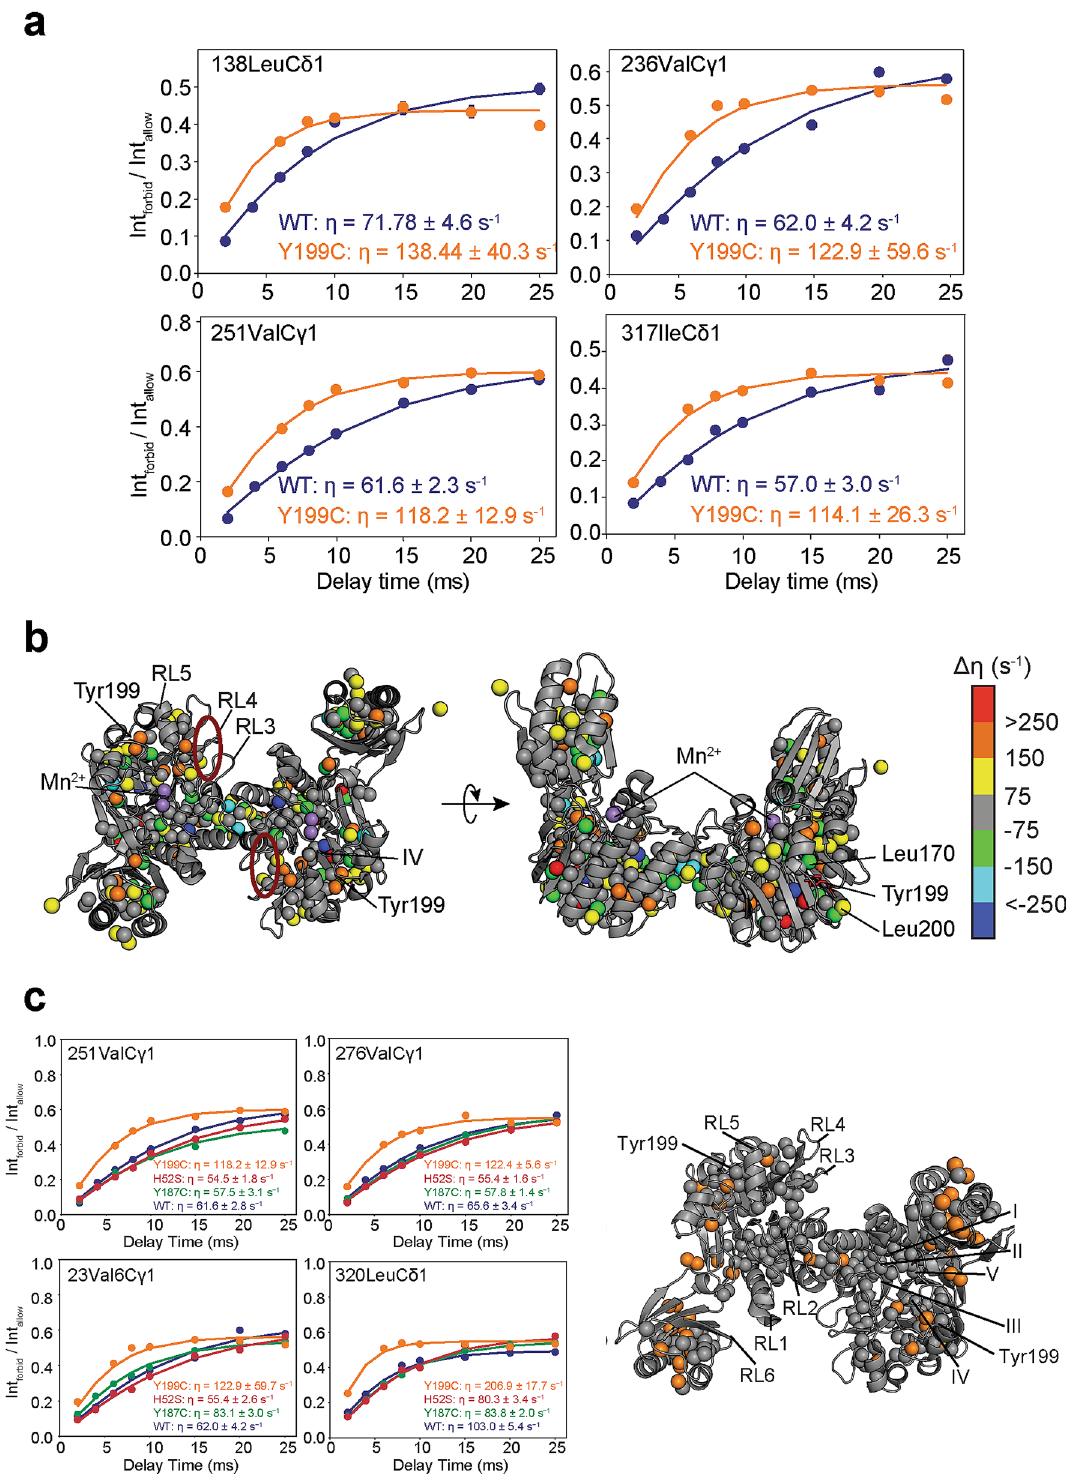
Figure 4. Pf Mre11 Y199C decreases the flexibility of the nuclease and capping domains. ( a ) Representative 1 H– 1 H cross- correlated “forbidden” triple-quantum relaxation curves. The data for wild type and Y199C are colored blue and orange, respectively. Error in the data points is derived from the noise in the spectra. The solid lines represent the fit of the data as described in the Material and Methods. Calculated η rates are given in the lower right corners. ( b ) Δη between wild type and Y199C are mapped on the structure of Pf Mre11 ND and are colored according to the associated gradient. The position of various residues, structural motifs, and catalytic Mn 2+ ions referred to in the text are indicated. A red circle indicates the position of the conserved basic patch. ( c ) Representative 1 H– 1 H cross-correlated “forbidden” triple-quantum relaxation curves for wild type (blue), H52S (red), Y187C (green), and Y199C (orange). Side-chain methyl groups that have larger η rates in only the Y199C mutant are highlighted in the structure of Pf Mre11 ND as orange